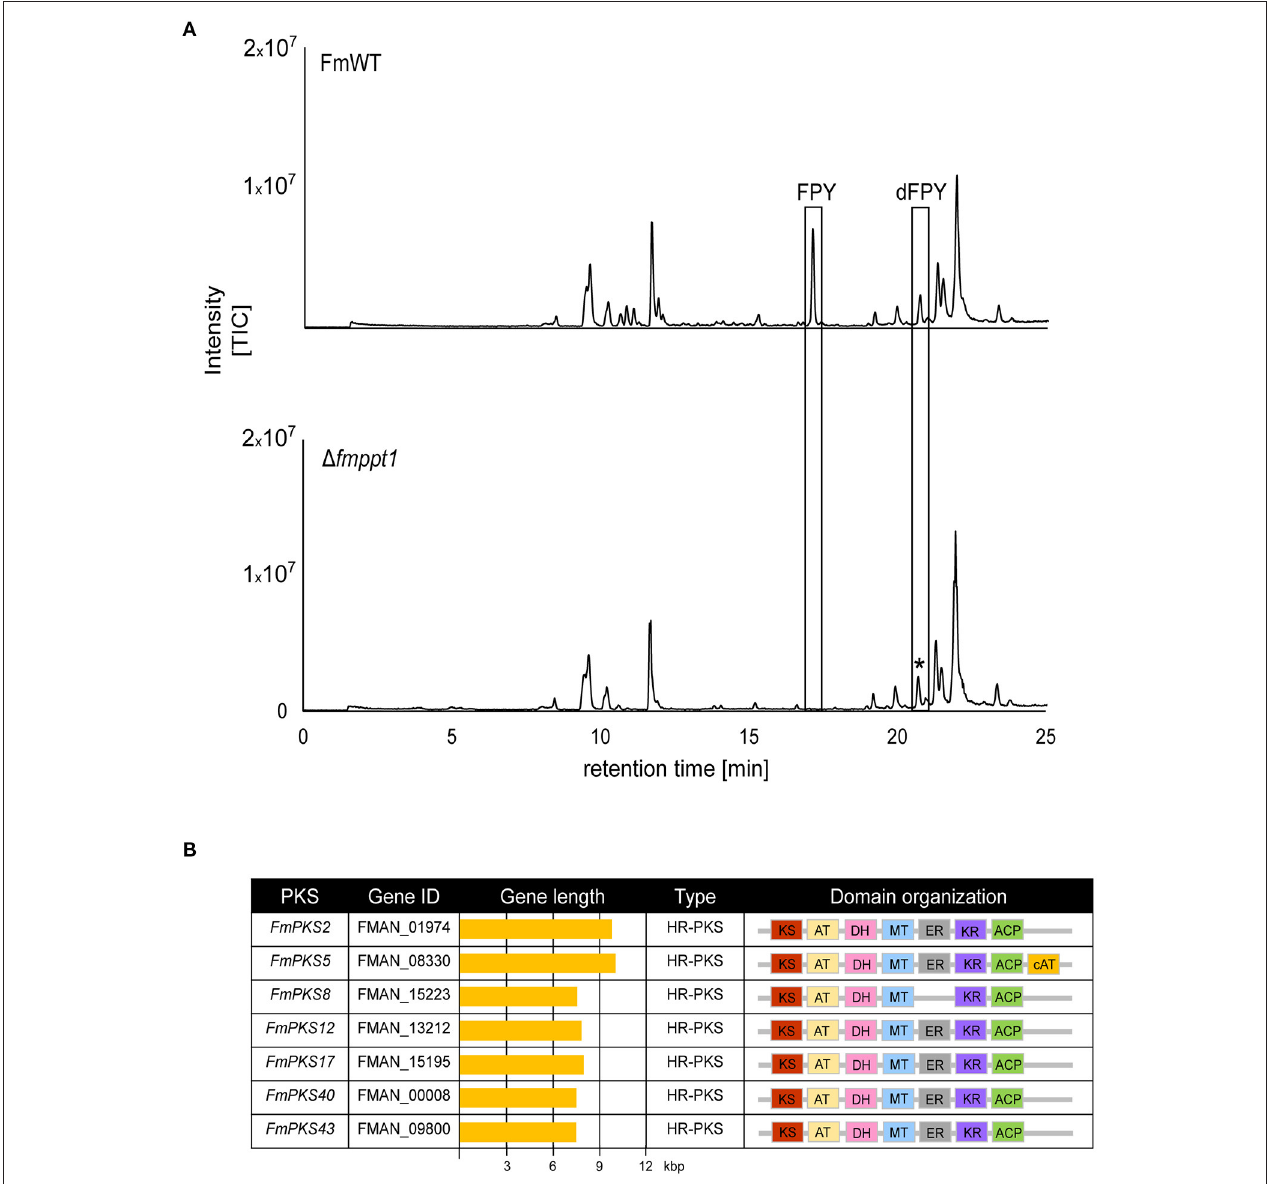
FIGURE 5 | Fusapyrone (FPY) and deoxyfusapyrone (dFPY) are PKS-derived metabolites. (A) HPLC-HRMS chromatograms of supernatants from F. mangiferae (FmWT) and 1 fmppt1 grown for 7 days at 30 ◦ C in the dark in liquid ICI supplemented with 6mM NaNO 3 as sole nitrogen source. Experiments were performed in triplicates. Peaks for FPY and dFPY (boxed) are present in FmWT but absent from 1 fmppt1 cultures. The asterisk (*) indicates that the observed signal in the 1 fmppt1 chromatogram with a similar retention time as dFPY is distinct from dFPY since the signal has a different mass. TIC chromatograms (positive ESI-mode) range from m/z 100 to 1,000. (B) Overview of PKS-encoding candidate genes for FPY biosynthesis. Sequences were retrieved from the publicly available genome sequence of F. mangiferae MRC7560 (Niehaus et al., 2016a). Depicted are the key enzymes, gene IDs, gene lengths, PKS types as well as the predicted domain organizations. Domain organization was analyzed using the NCBI Conserved Domain (Marchler-Bauer et al., 2017), InterPro (Blum et al., 2021), SBSPKSv2 (Khater et al., 2017); and the PKS/NRPS Analysis Web-site (Bachmann and Ravel, 2009). KS (red), keto synthase; AT (yellow), acyltransferase; DH (pink), dehydratase; MT (blue) C-methyltransferase; ER (gray) enoylreductase; KR (violet), ketoreductase; ACP (green), acyl carrier protein; cAT (orange), carnitine acyltransferase.